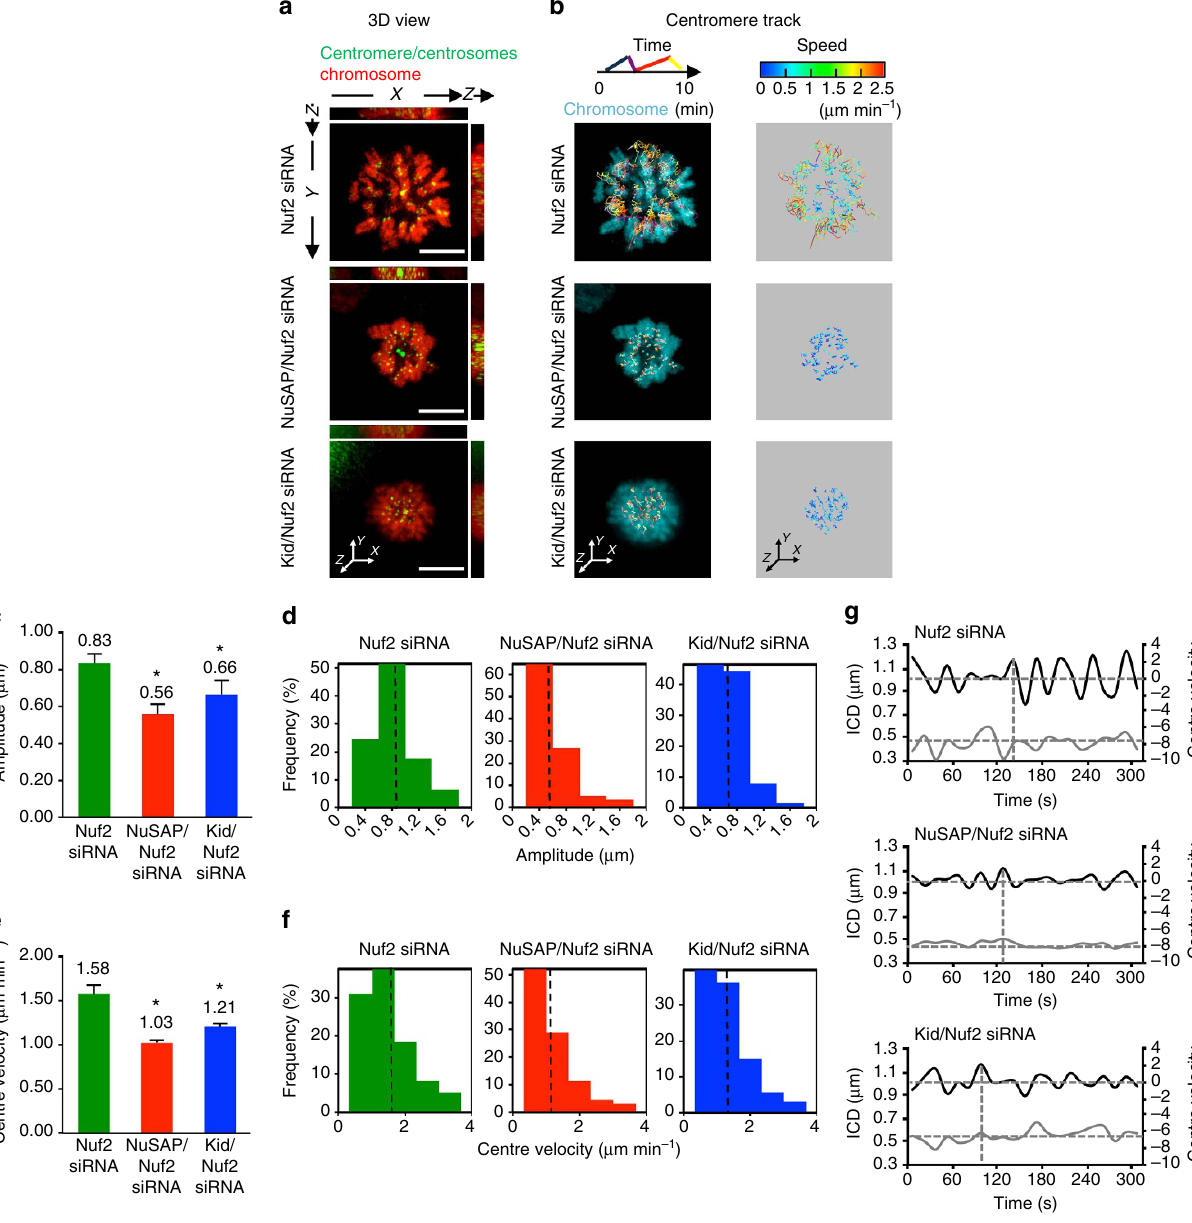
Figure 6 | NuSAP tunes the polar ejection force with Kid at interpolar microtubules in monopolar cells. ( a ) Representative images of the 3D view using xz and yz projections in Nuf2-, NuSAP/Nuf2- or Kid/Nuf2-depleted monastrol-treated monopolar HeLa cells stably expressing mCherry-H2B. Centromeres were marked with GFP-CENPA and centrosomes with GFP-centrin. Scale bar, 5 m m. ( b ) Representative images of 3D centromere tracks colour-coded for time and velocity. ( c , d ) Bar chart and histogram representing the average ( c ) and the distribution ( d ) of the amplitude of centromere oscillation in Nuf2-, NuSAP/Nuf2- or Kid/Nuf2-depleted monopolar cells. Error bars represent þ s.e.m. * P o 0.001, by t -test. ( e , f ) Bar chart and histogram representing the average ( e ) and the distribution ( f ) of the centre velocity. Error bars represent þ s.e.m. * P o 0.001, by t -test. ( g ) Representative velocity (black line) and ICD (grey line) versus time plots of the projected centre in a sister centromere pair in the control, NuSAP- or Kid-depleted monopolar cells. The sign of the velocity indicates the direction of centromere movement. The average of the ICD (horizontal) and the minimum (horizontal) and maximum velocities (vertical) are indicated by the dashed lines.